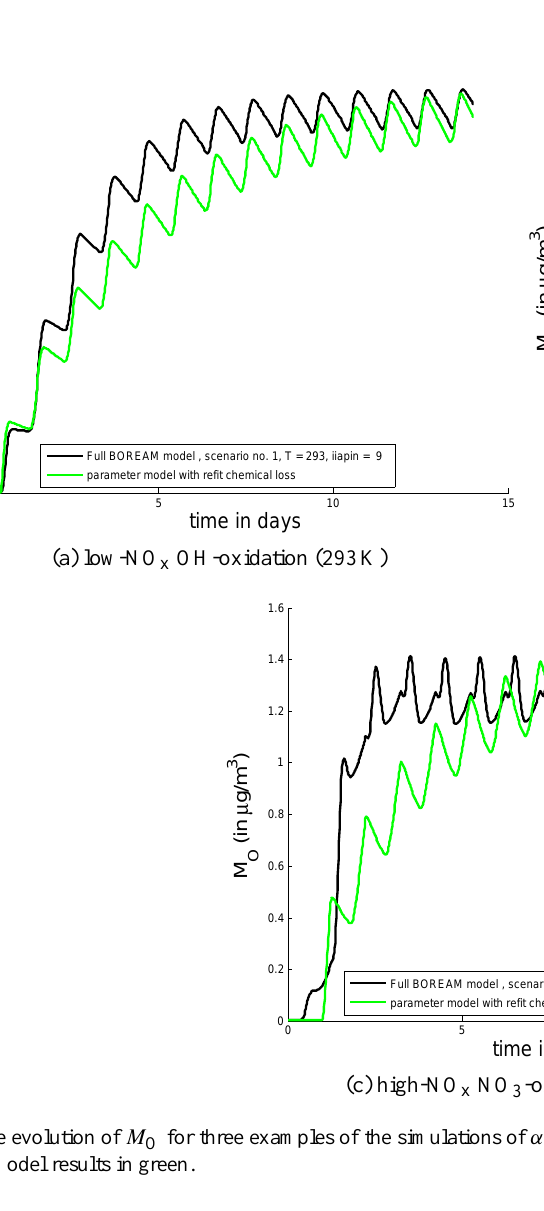
20 µg m − 3 . The yields in both low-NO x scenarios are about